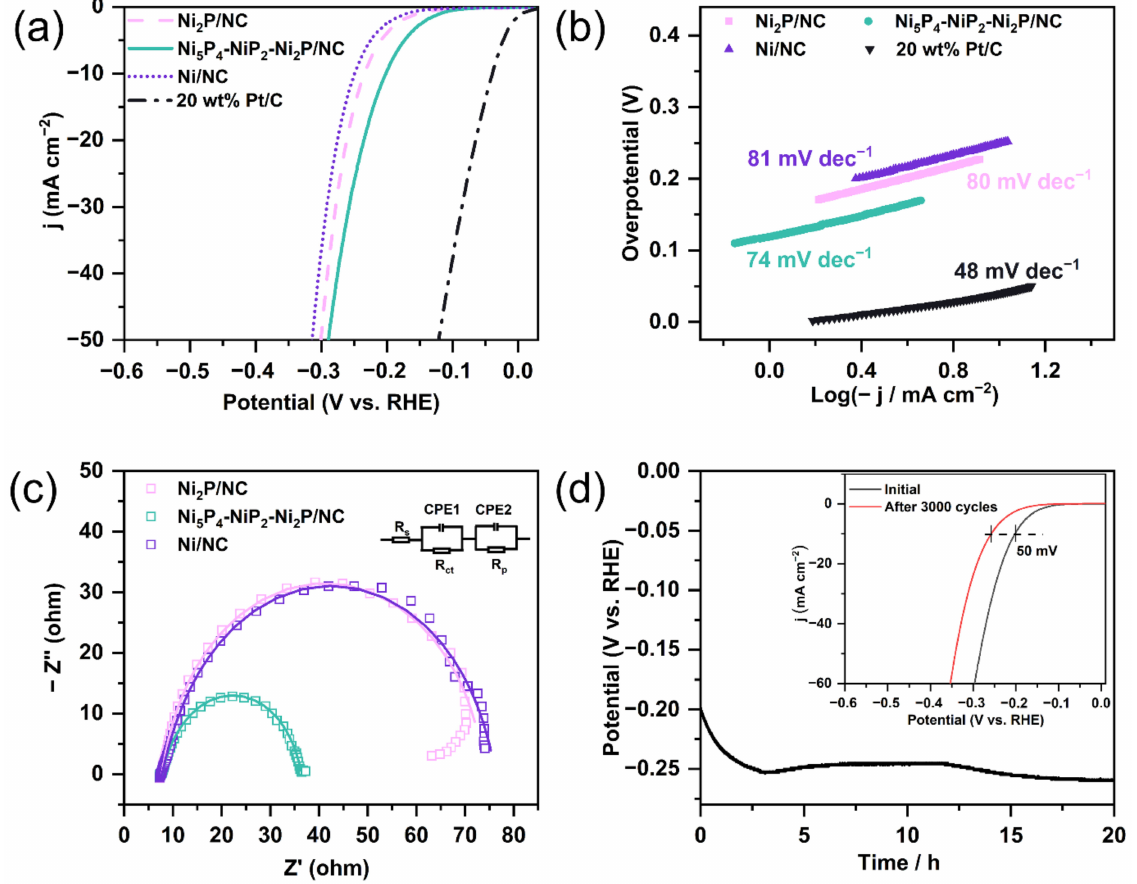
Figure 6. ( a ) Polarization curves of Ni/NC, Ni 2 P/NC, Ni 5 P 4 -NiP 2 -Ni 2 P/NC, and Pt/C in the 1 M KOH; ( b ) the Tafel plots derived from Figure 6a; ( c ) Nyquist plots of Ni/NC, Ni 2 P/NC, and Ni 5 P 4 -NiP 2 -Ni 2 P/NC at the overpotential of 220 mV; ( d ) Chronopotentiometric curves of Ni 5 P 4 - NiP 2 -Ni 2 P/NC catalyst with a constant current density of 10 mA cm − 2 for 70,000 s in 1 M KOH, insert is polarization curves of initial and after 3000 cycles of CV scans at 100 mV s − 1